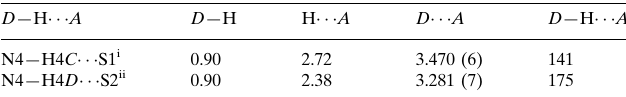
Hydrogen-bond geometry (A˚ , (cid:4)